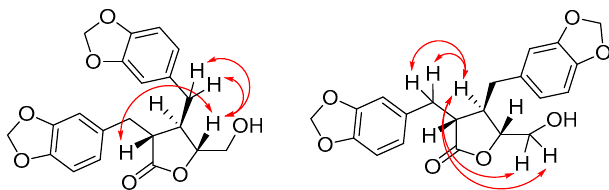
Figure 3. Selected NOESY correlations showing trans,trans -relationship of hydroxymethyl lactone lignan analogue 4bb